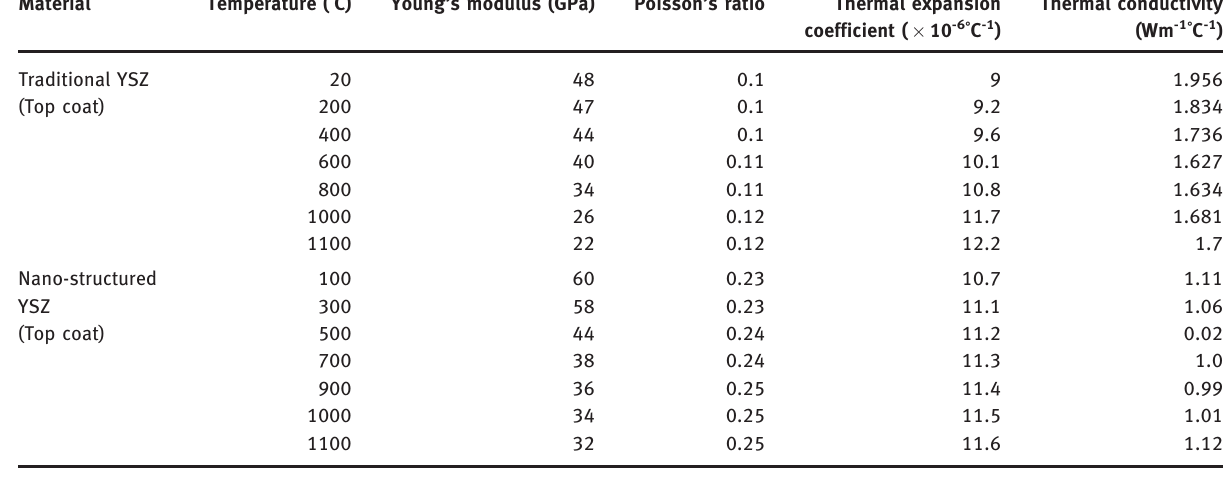
Table 1: Material performance parameters of traditional and nano-structured YSZ [1, 25 – 27]. Material